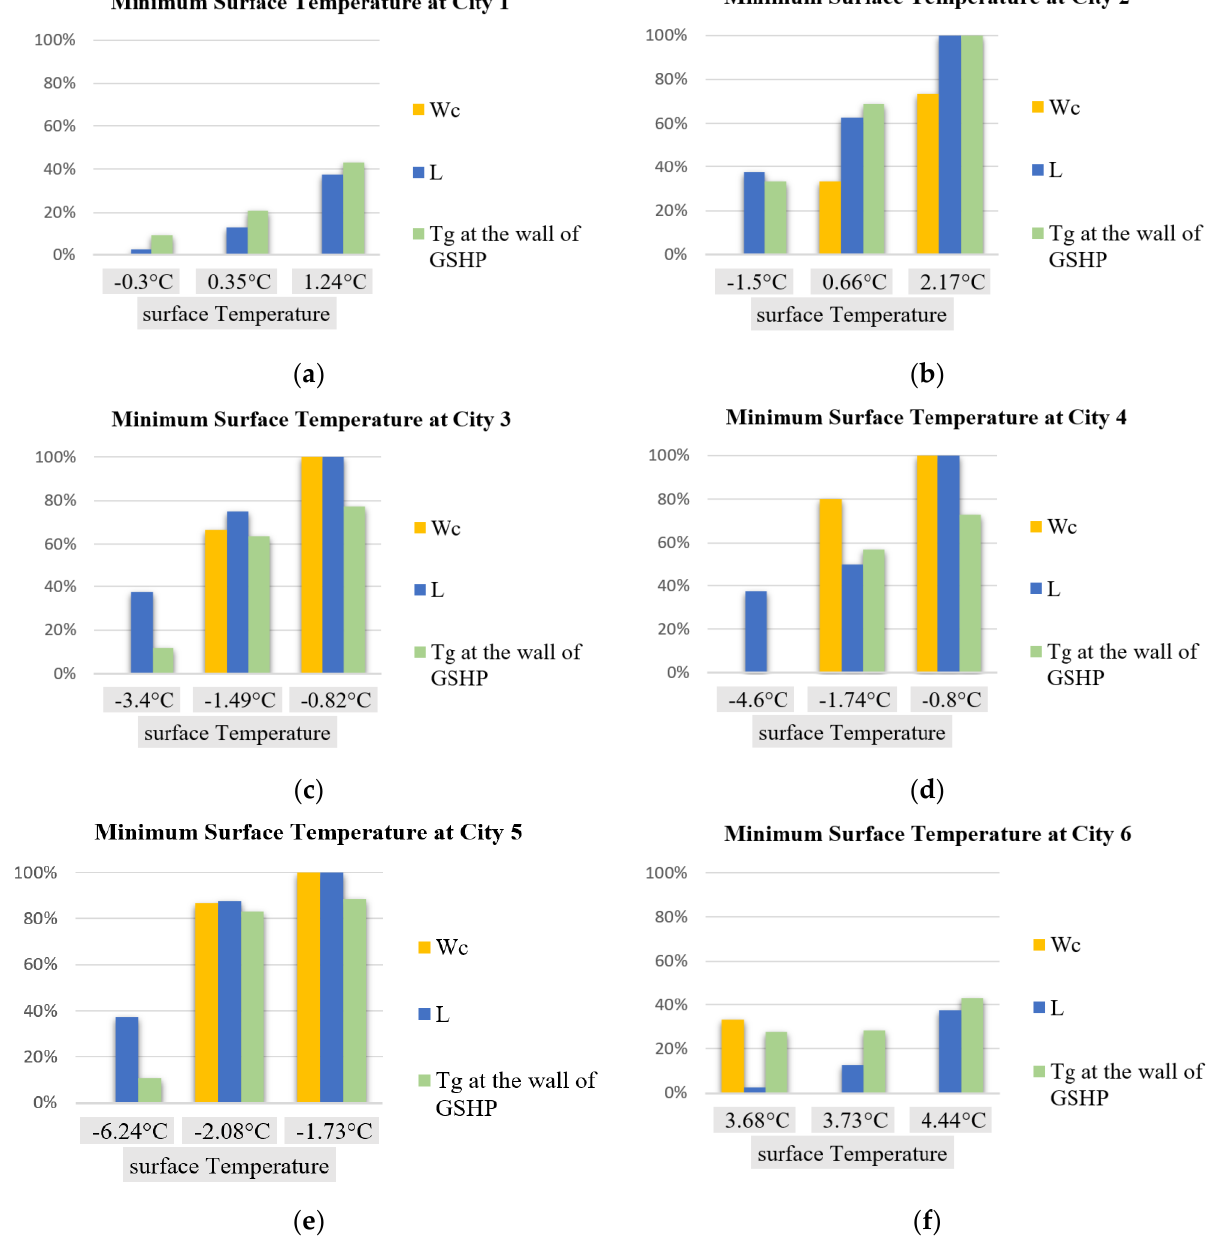
Figure 14. Surface temperature at different GSHP sizes for each of the six other locations: (a) Albu- querque, NM; (b) Amarillo, TX; (c) Baltimore, MD; (d) Columbus, OH; (e) Lexington, KY; and (f) Portland, OR. Table 5. Summary of a heat pipe performance installed in different locations (city 1: Albuquerque, NM; city 2: Amarillo, TX; city 3: Baltimore, MD; city 4: Columbus, OH; city 5: Lexington, KY; city 6: